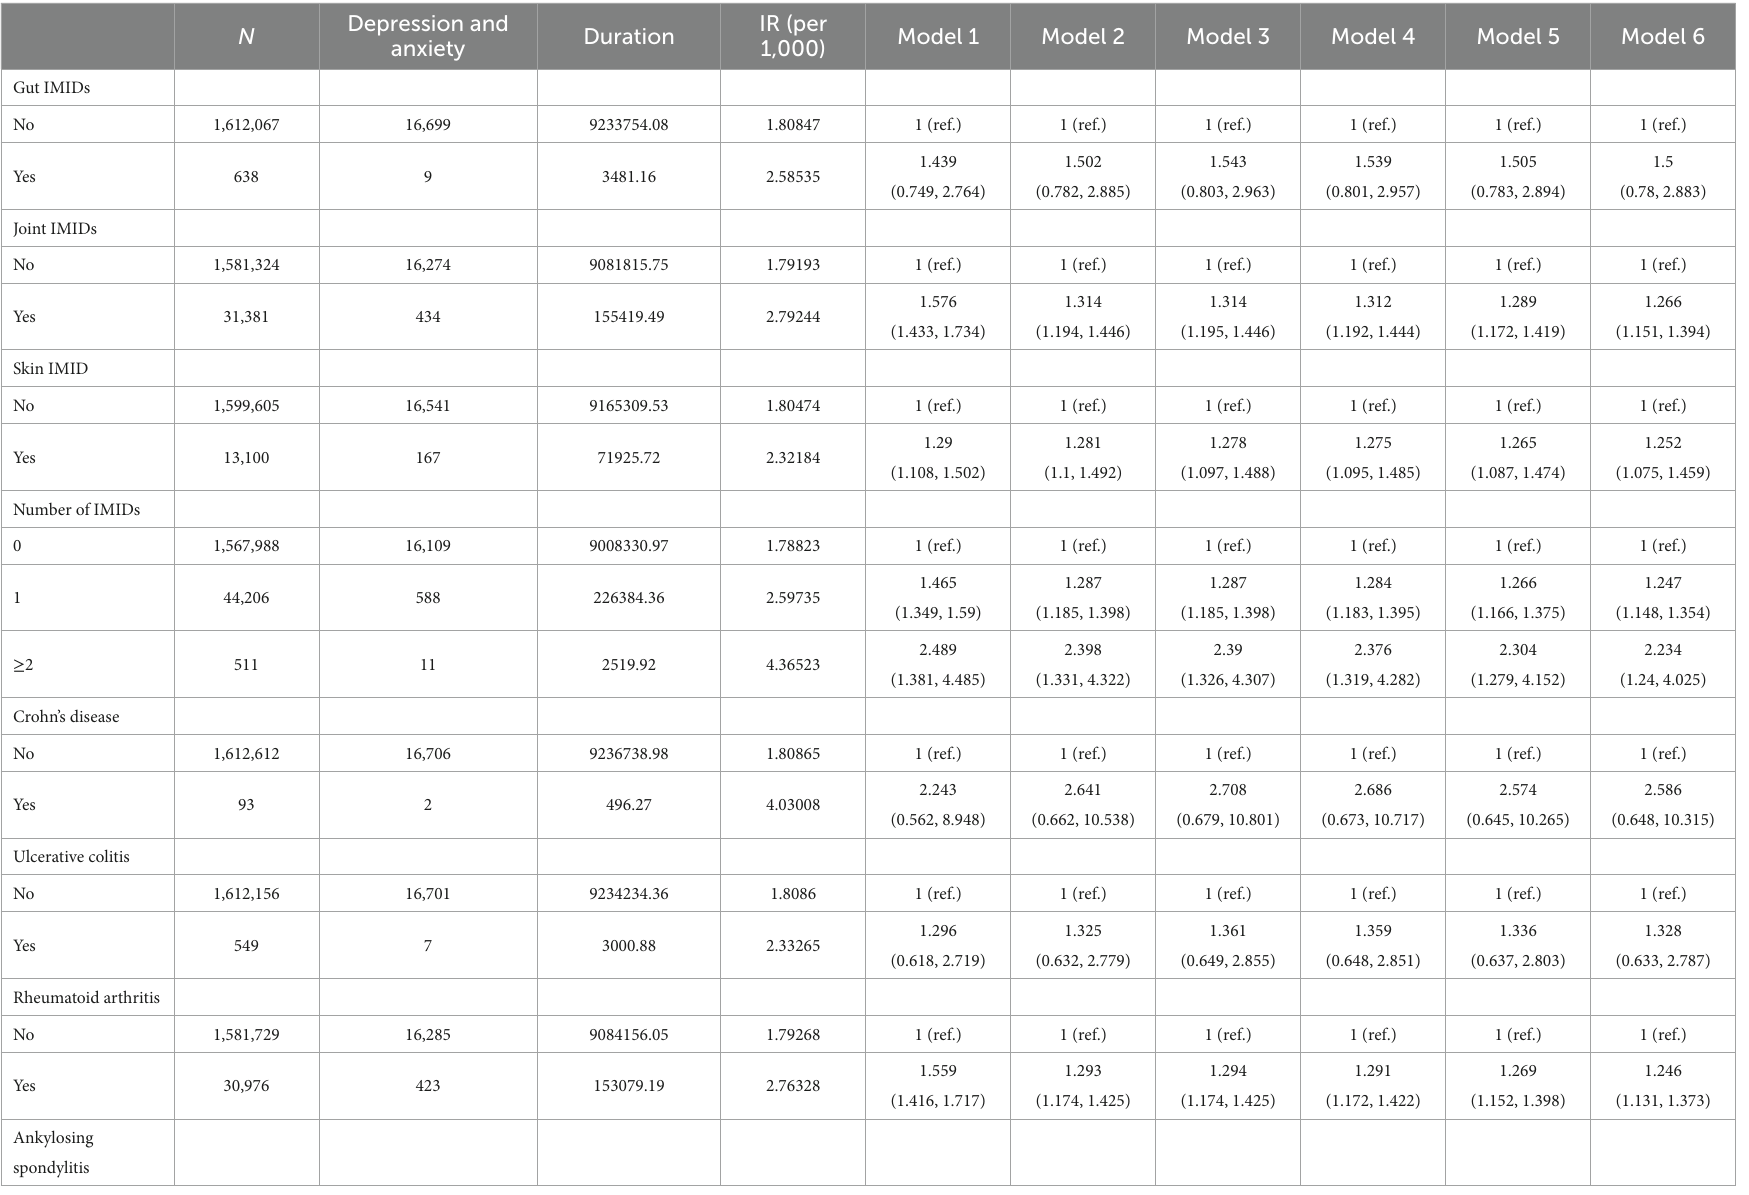
TABLE 6 Risk of developing both depression and anxiety according to the presence of immune-mediated inflammatory